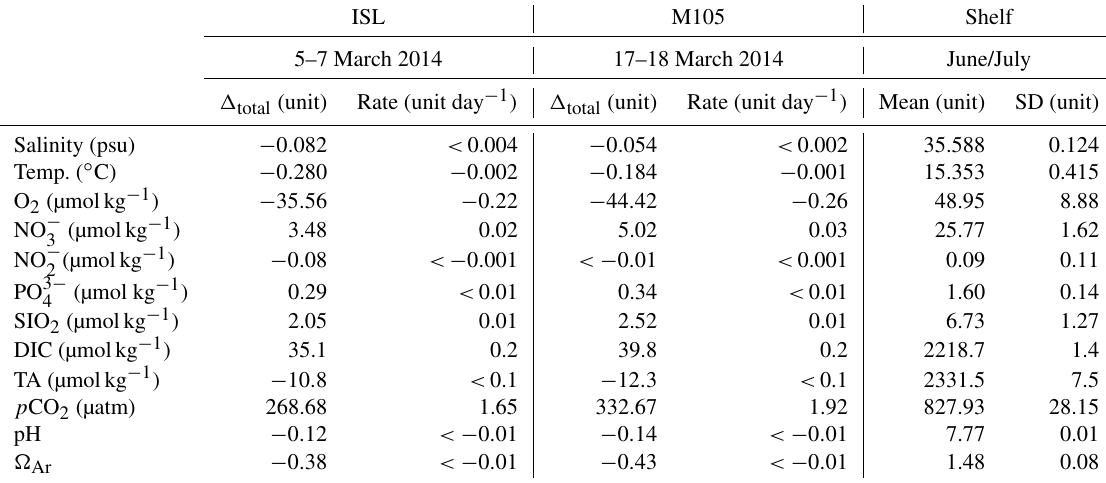
Table 1. Overview of detected concentration anomalies ( (cid:49) total ) within the ACME core ( σ θ = 26 . 35kgm − 3 − 1000) during the two surveys referenced against prevailing conditions at the shelf. Rate estimates are based on the lifetime of the ACME derived from satellite sea level anomaly data (ISL: 163 days, M105: 173 days). Values for the average shelf profiles are given in order to illustrate local variability at